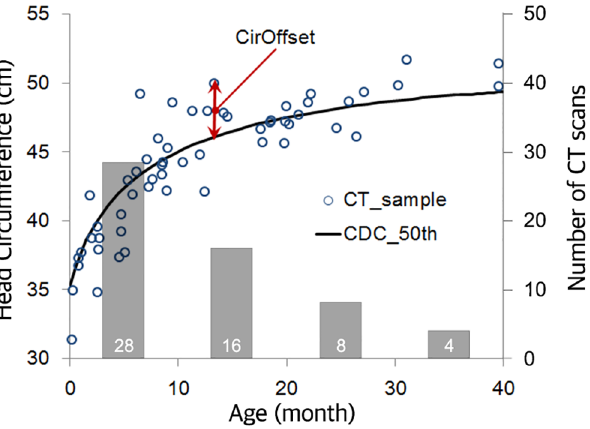
Fig 3. Pediatric head circumference and CirOffset relative to the CDC median head circumference curve.